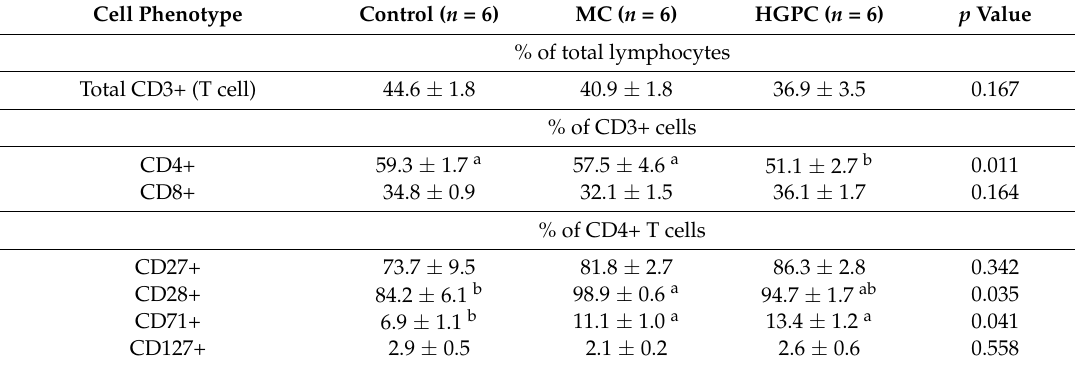
Table 4. Splenocyte phenotypes of lactating dams fed Control (100% FC), Mixed Choline (MC; 50%